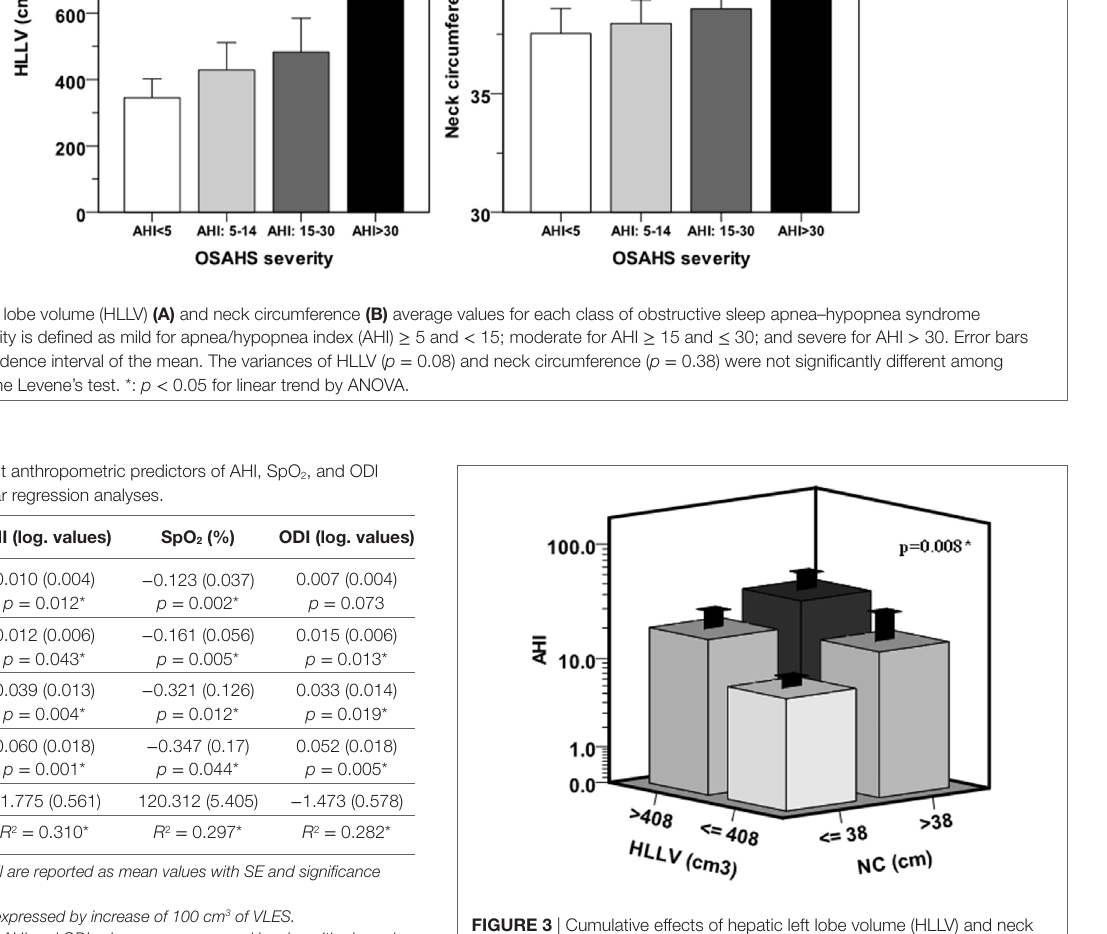
FigUre 3 | Cumulative effects of hepatic left lobe volume (HLLV) and neck circumference (NC) on the apnea/hypopnea index (AHI). Subjects were categorized in four subgroups according to the median values of HLLV ( = 408 cm 3 ) and NC ( = 38 cm) in the whole cohort. The variances of AHI values were not significantly different among the four subgroups by the Levene’s test ( p = 0.07). * p < 0.05 by ANOVA.